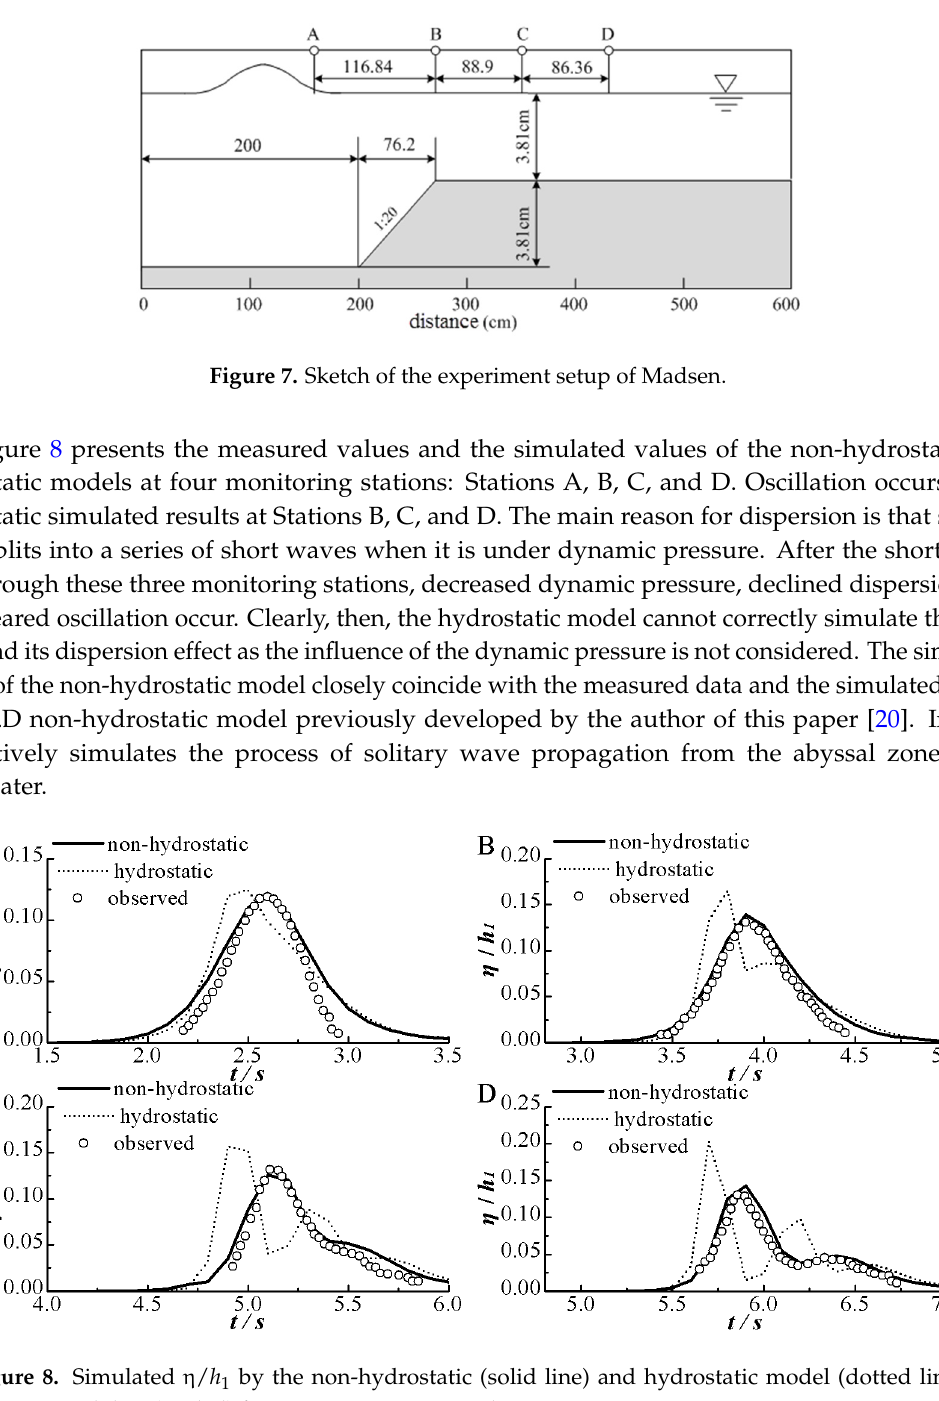
Figure 8. Simulated η / h 1 by the non-hydrostatic (solid line) and hydrostatic model (dotted line); experimental data (circled) from Stations A, B, C, and D.